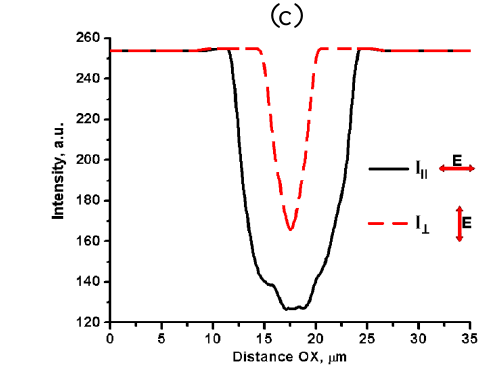
, f = 100 kHz) cloud of “short/thin” Au NRs rms